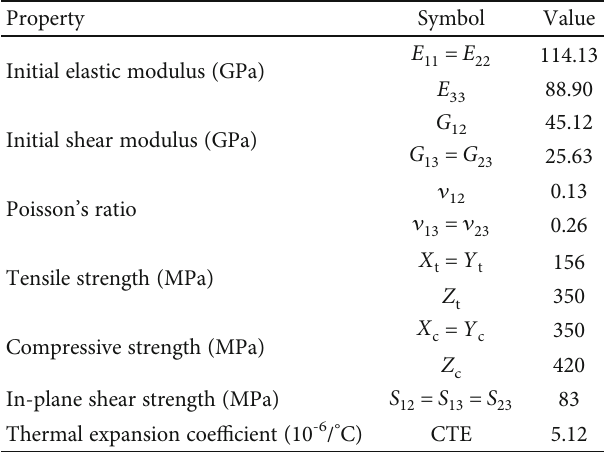
Figure 2: The measured stress-stain curves provided by material suppliers and the fi tted results for a 2D plain-woven C/SiC composite plate under uniaxial tension (a) and shear (b) loading. Table 1: Mechanical and thermal properties of 2D plain-woven C/SiC composite